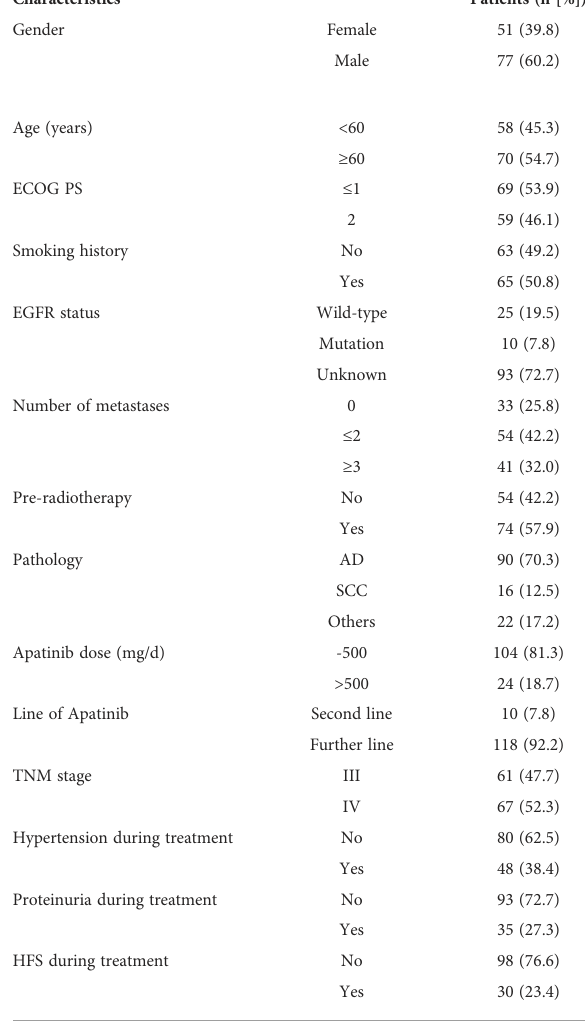
TABLE 1 Patients clinical and pathological characteristics.